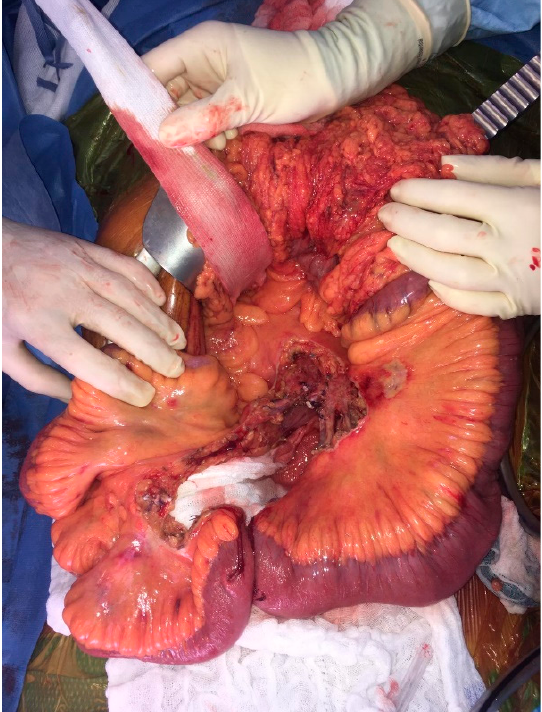
Figure 4. Operative view showing the persisting small bowel after resection (on the proximal side, 2.50 m was preserved; on the distal segment, 1 m was persistent).